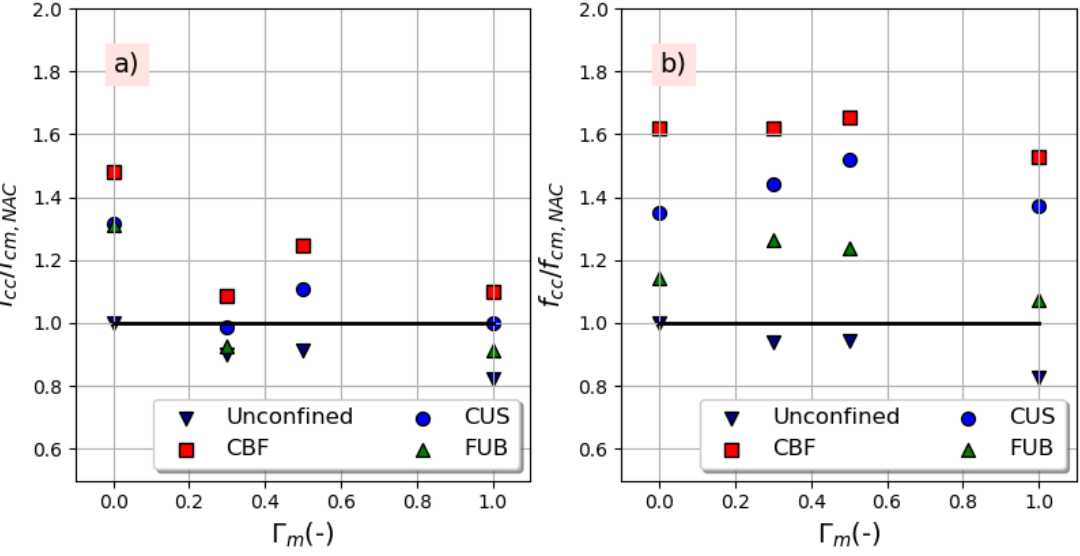
Figure 10. Strength recovery with replacement ratio: ( a ) without air-entraining agent, ( b ) with 4% air-entraining agent.